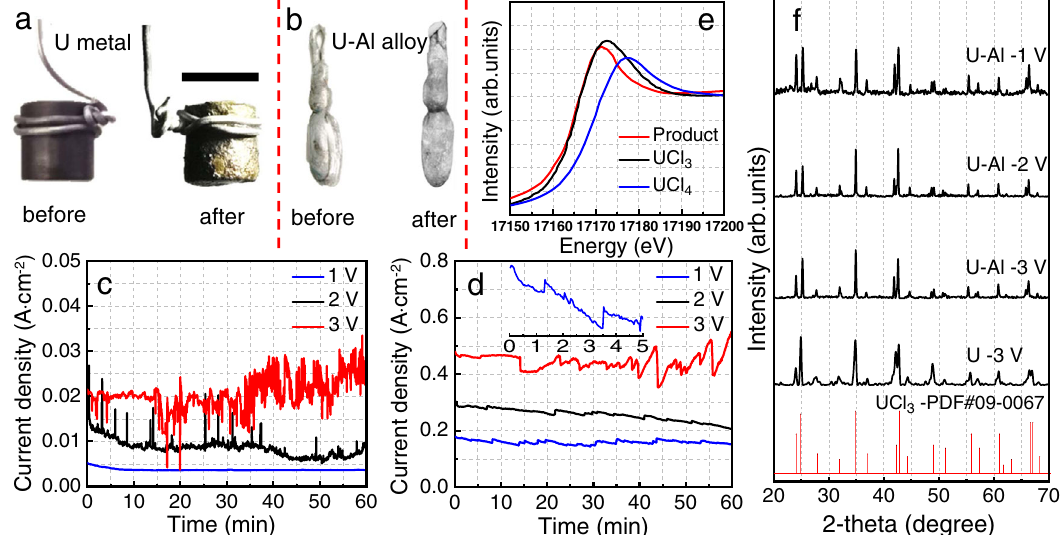
Fig. 2 Anodic processes of U and Al-U alloy. Images of a U metal anode and b Al-U alloy anode before and after electrolysis. Scale bar = 1 cm. Current versus time plots for three electrode potential using c U anode and d Al-U alloy anode in NaAlCl 4 melt at 453 K. e U L 3 -edge XANES spectra of standards UCl 4 and UCl 3 , and the U anode product of electrolysis at 3 V vs. Al (quenched suddenly to the solid state at room temperature without any other treatment). f XRD patterns of anode products after electrolysis of pure U at 3 V and the Al-U alloy at 1 V, 2 V and 3 V vs. Al; and standard pattern for UCl 3 .